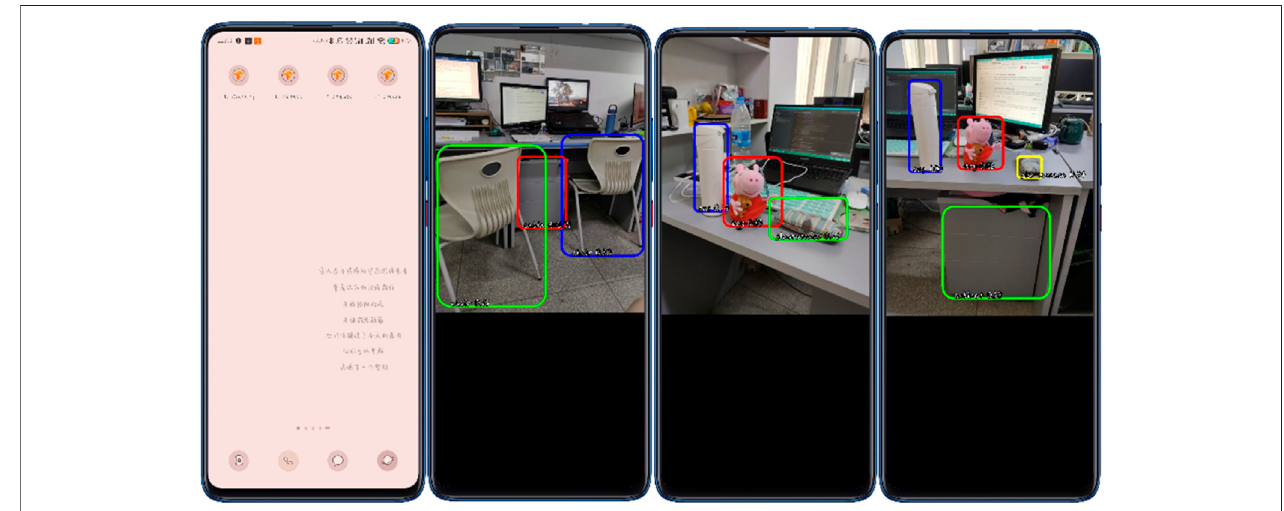
FIGURE 12 | Deployment of real-time detection model on the Android